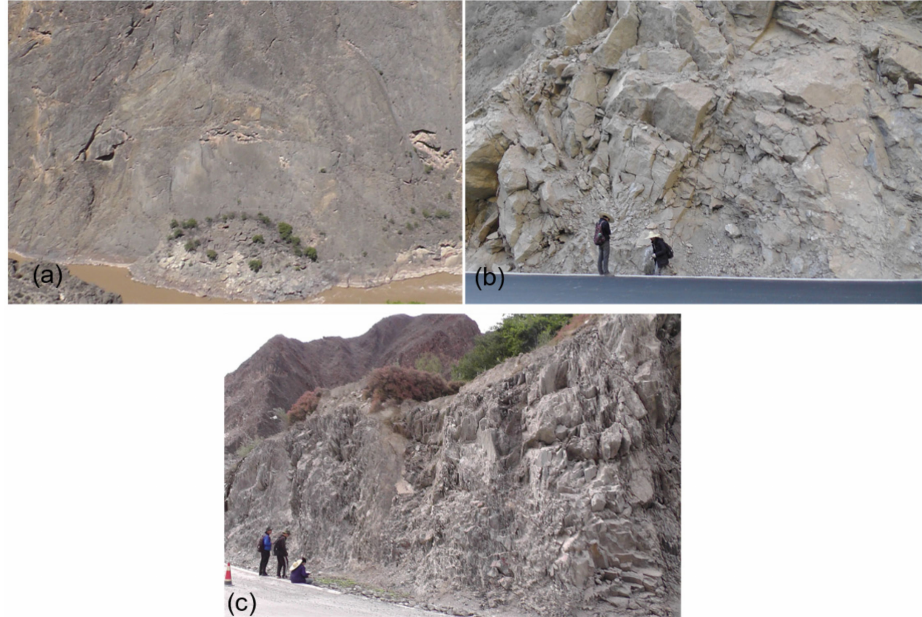
Figure 1. A typical case of different fracturing degrees of source rock on the upstream reaches of the Jinsha River: ( a ) low fracturing degree of source rock; ( b ) medium fracturing degree of source rock; and ( c ) high fracturing degree of source